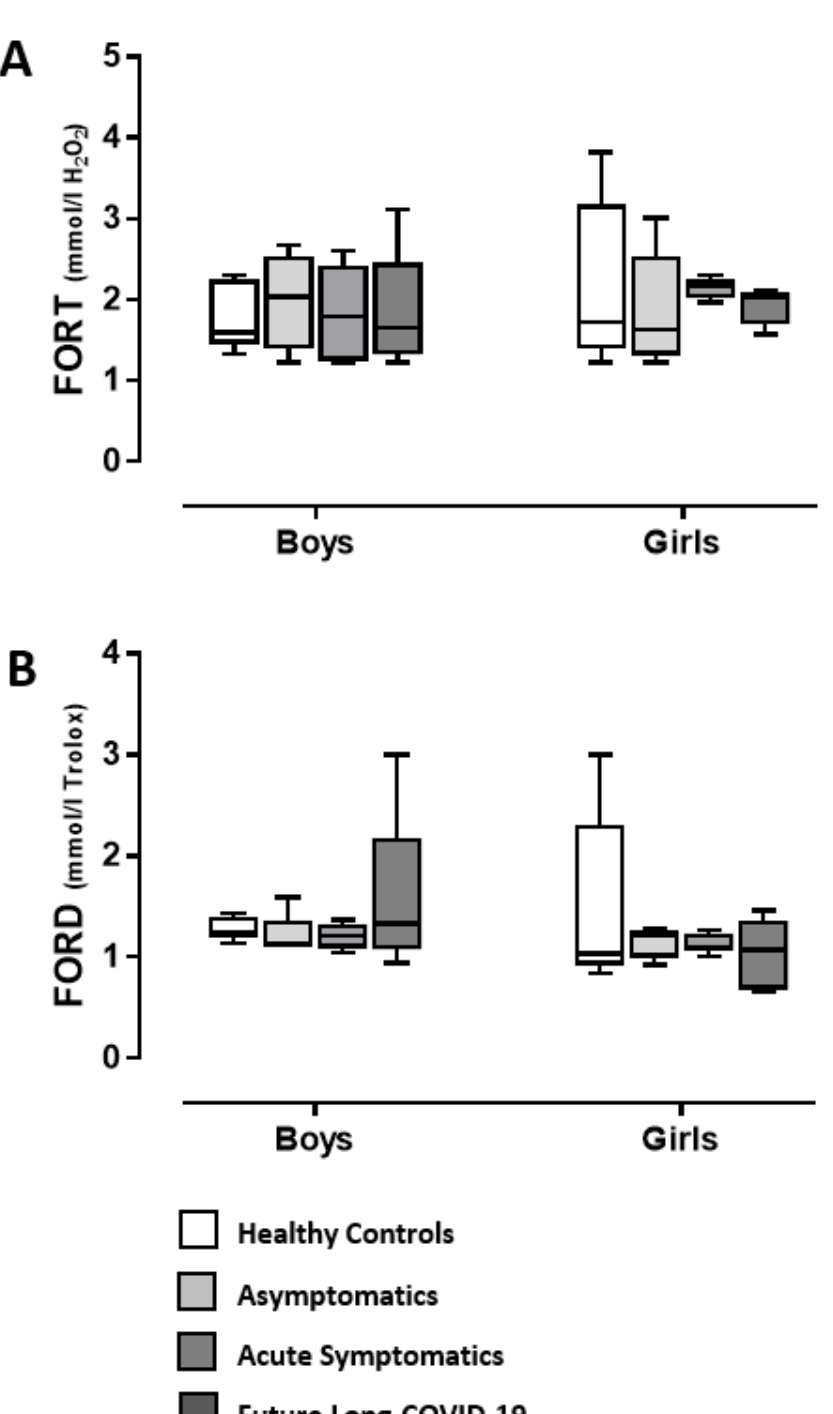
Figure 2. Serum FORT ( A ) and FORD ( B ) in COVID-19 adolescents and healthy controls. According to their COVID-19 related outcomes, the recruited individuals were divided into 3 groups: asymptomatics, acute symptomatics, and symptomatics that over time developed long-COVID-19 symptoms (“future long-COVID-19”); as a control group we analyzed the serum of age-matched healthy controls that did not contract the infection. Boxes indicate the lower and upper quartiles. The vertical lines extending from each box represent the minimum and maximum values.